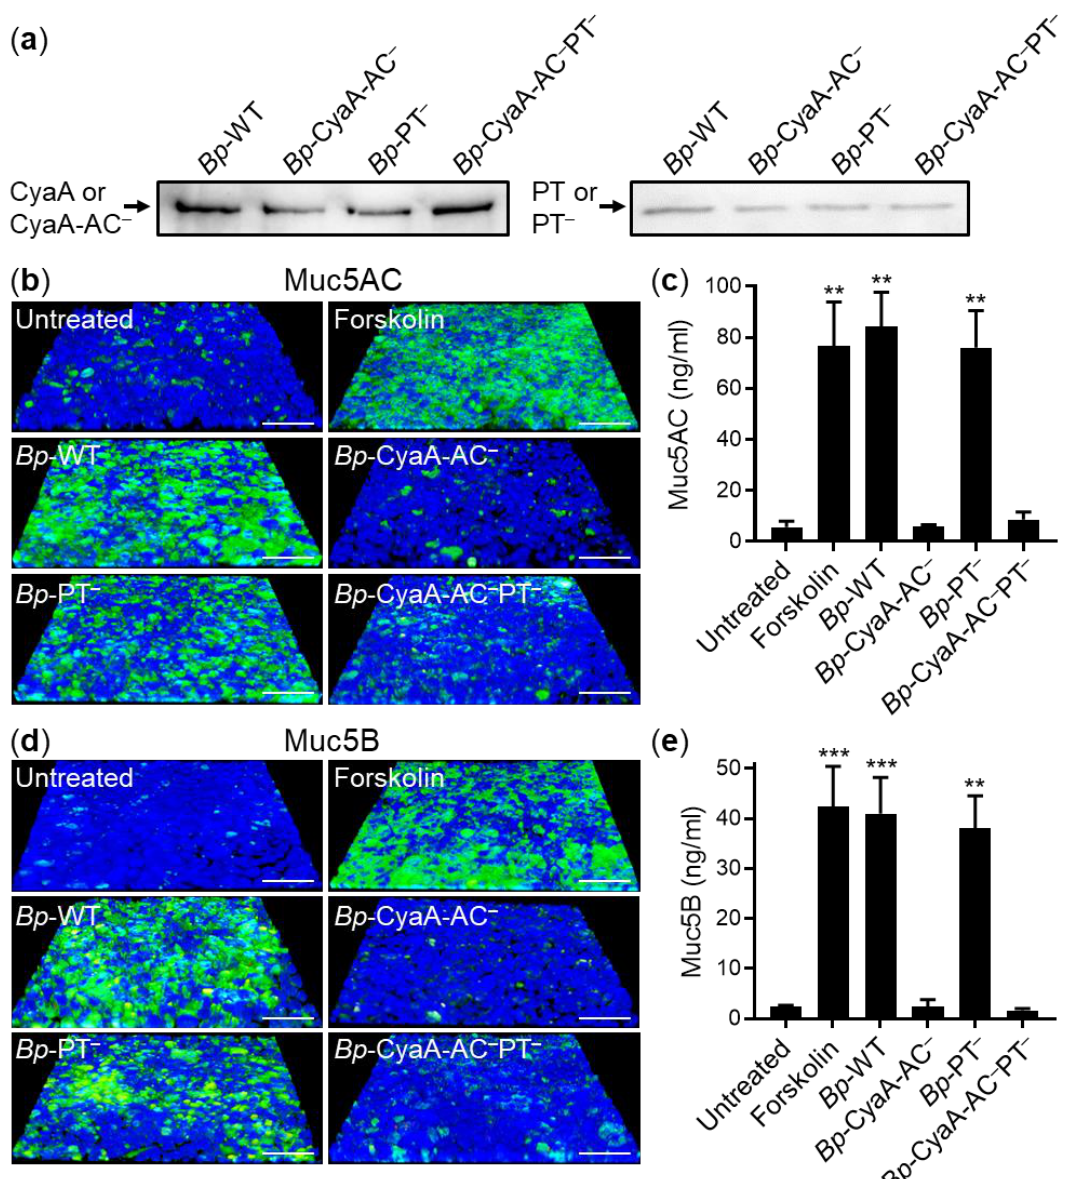
Figure 4. B. pertussis -secreted CyaA alone triggers Muc5AC and Muc5B production by infected epithelial cells. ( a ) B. pertussis Tohama I ( Bp -WT) and its isogenic mutant strains ( Bp -CyaA-AC – , Bp -PT – and Bp -CyaA-AC – PT – ) secrete the toxins CyaA and PT and/or their respective toxoids. Bacteria were cultured in complete SS medium in the presence of 2 mM CaCl 2 to an OD 600 of 1 and the secreted proteins were detected by Western blotting. Monoclonal antibodies specific for CyaA and CyaA-AC – or for the S1 subunit of PT and PT – were used to detect the secreted proteins. ( b – e ) ALI-grown polarized VA10 cell layers were infected from the apical side with Bp -WT or its isogenic mutant strains at an MOI of 50:1 for 24 h at 37 ◦ C. The layers were fixed with 4% PFA, immunofluorescently labeled for Muc5AC ( b ) and Muc5B ( d ) (green) and analyzed by confocal microscopy. Cell nuclei were stained with DAPI (blue) and the VA10 cell layers apically treated with 20 µ g/mL of forskolin are shown as positive controls. Representative images of Muc5AC and Muc5B staining from at least five independent experiments are shown. Scale bars correspond to 50 µ m on x-axis at the front edge. The amounts of Muc5AC ( c ) and Muc5B ( e ) secreted onto the apical cell layers were quantified by ELISA. Bars represent means with SEM of Muc5AC and Muc5B production from three independent experiments. ** p < 0.01; *** p < 0.001 compared with untreated cell